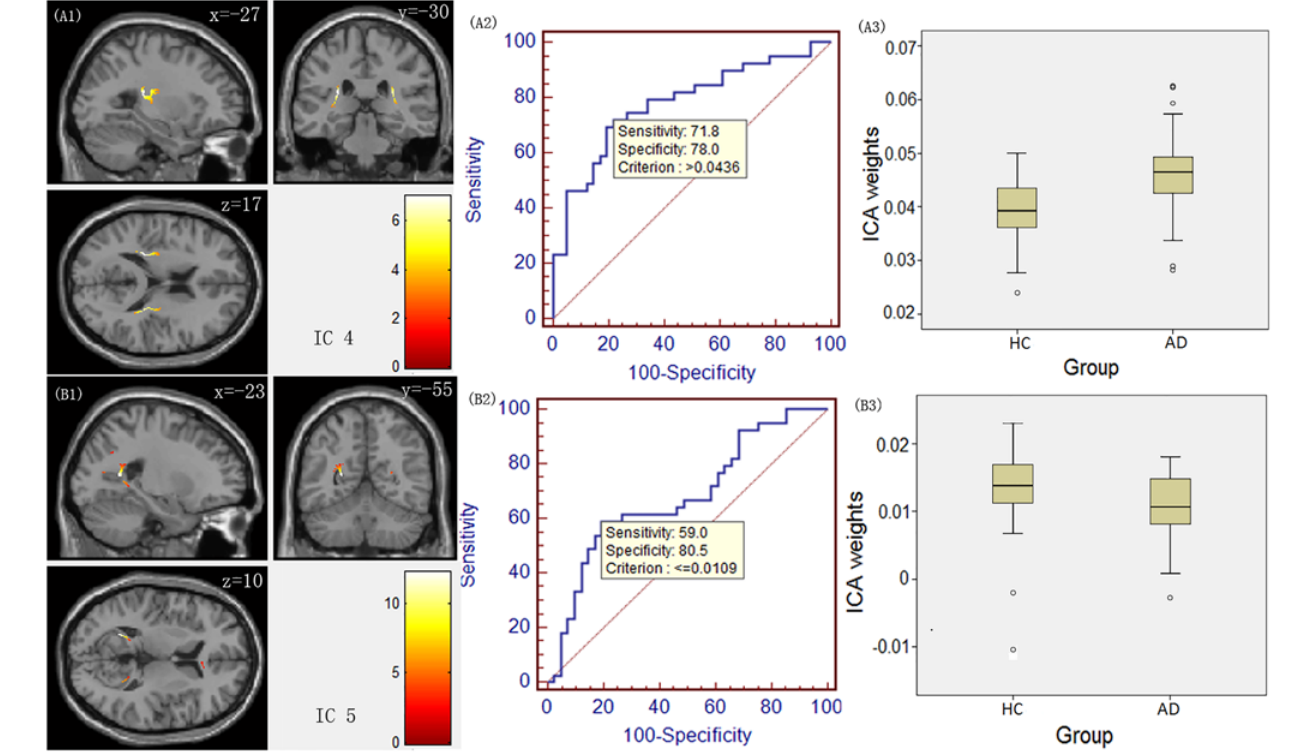
Fig 2. IC spatial maps displaying the covariant FA changes in white matter in AD patients compared to HCs for ICs 4 and 5. The colour bar represents Z-score. The middle panel displays their corresponding receiver operating characteristic (ROC) curves, and the right panel displays a boxplot of the between-group differences in ICA